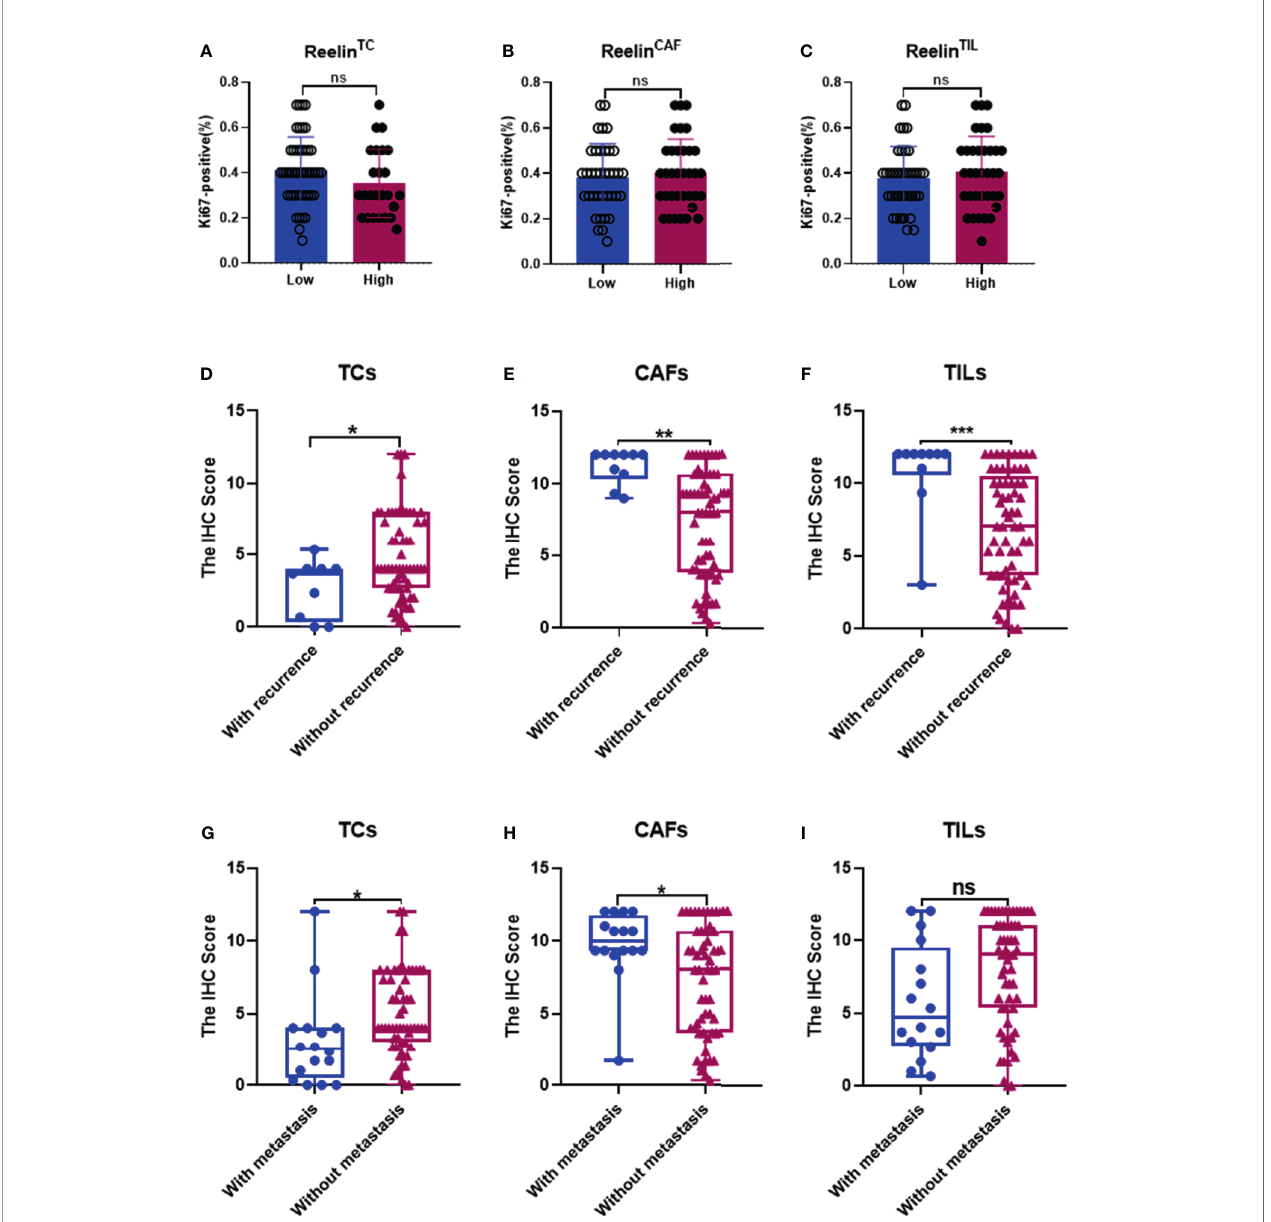
FIGURE 3 | Correlation between Ki-67 in TCs and Reelin in TCs, CAFs, and TILs (A – C) . Correlation between Reelin and postoperative recurrence as well as distant metastasis, according to TCs (D, G) , CAFs (E, H) , and TILs (F, I) . *, ** and *** denote that differences were considered statistically signi fi cant with p < 0.05, p < 0.01 and p < 0.001 respectively. ns represented no statistical